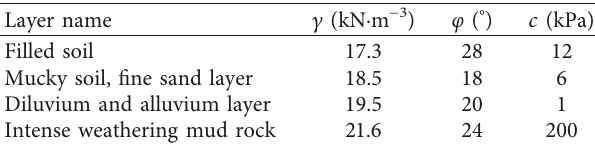
Table 4: Calculation parameters of surrounding rock.